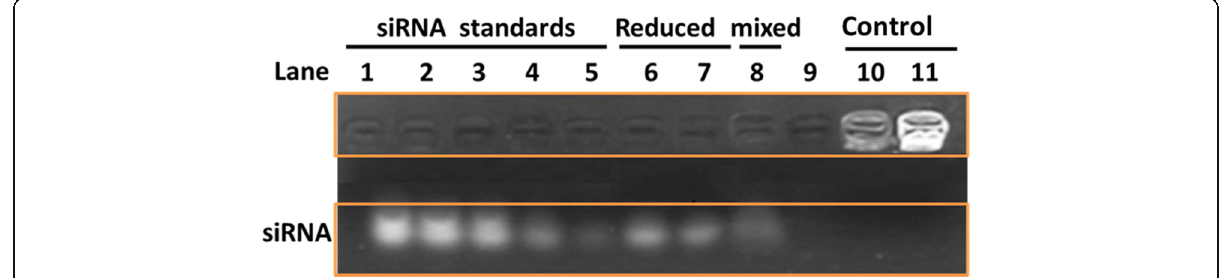
Fig. 3 AGE analysis of siRNA reversible binding to Apt-GS nanogels. Lanes 1 – 5: free siRNA with amount of 50, 40, 30, 20, and 10 pmol. Lanes 6 and 7:GS/siRNA and Apt-GS/siRNA with 10 mM GSH at 2 h. Lane 8: the mixture of free siRNA and Apt-GS NGs. Lanes 10 and 11: GS/siRNA and Apt-GS/siRNA complexes without 10 mM GSH as